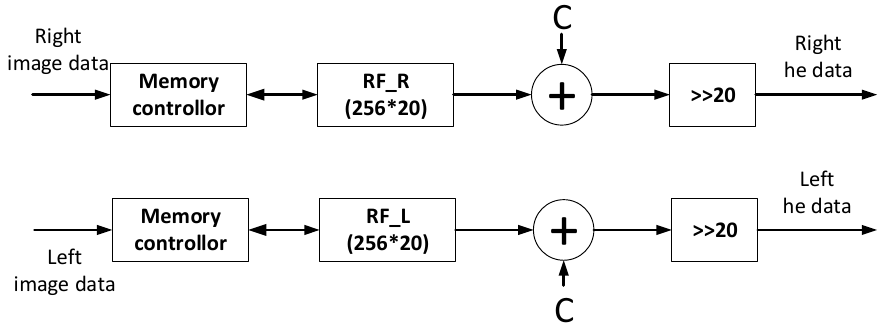
Figure 3. Architecture of histogram equalization.